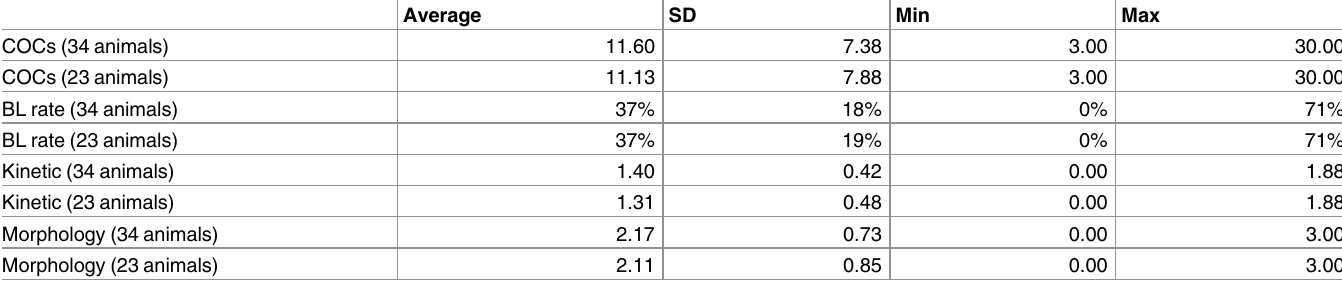
Table 1. Summaryof the IVP scores for the sample sets.